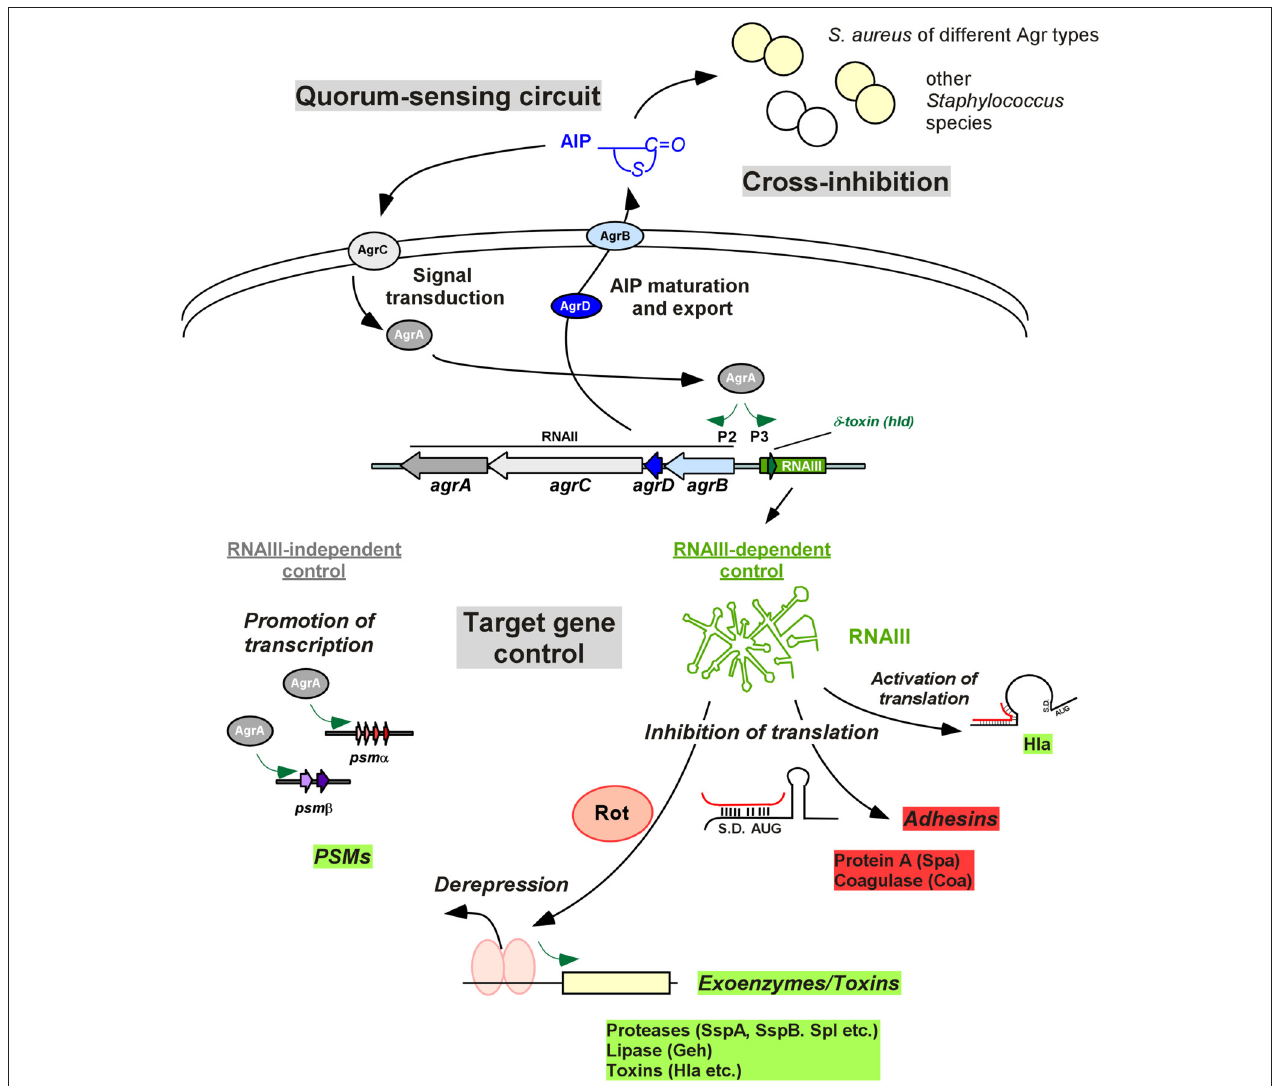
FIGURE 1 | Agr control in Staphylococcus . The quorum-sensing circuit is shown at the top left. The AIP signal is produced from the AgrD precursor by AgrB maturation and export. At a certain threshold concentration, AIP activates the AgrC-AgrA two-component system and phosphorylated AgrA activates transcription from the P2 promoter, resulting in auto-feedback regulation. An important feature of Agr is group specificity, resulting in cross-inhibition, i.e., inhibition of Agr activity, in strains belonging to other Agr specificity groups and other species (top right). Target gene control is shown at the bottom. Most Agr targets are regulated via RNAIII, whose transcription is increased by AgrA, via the P3 promoter. RNAIII also contains the gene for delta-toxin ( hld ). RNAIII controls target genes by base pairing with 5 ′ UTRs, in most cases inhibiting translation. This is used for direct inhibition of Agr-inhibited target genes such as protein A, while inhibition of translation of the repressor Rot leads to de-repression of transcription of many of the classical Agr target toxins, such as alpha-toxin. AgrA also increases transcription of the psm α and psm β operons, encoding PSM peptides, in an RNAIII-independent mode of Agr target gene regulation. S.D., Shine/Dalgarno sequence; AUG, start codon of controlled